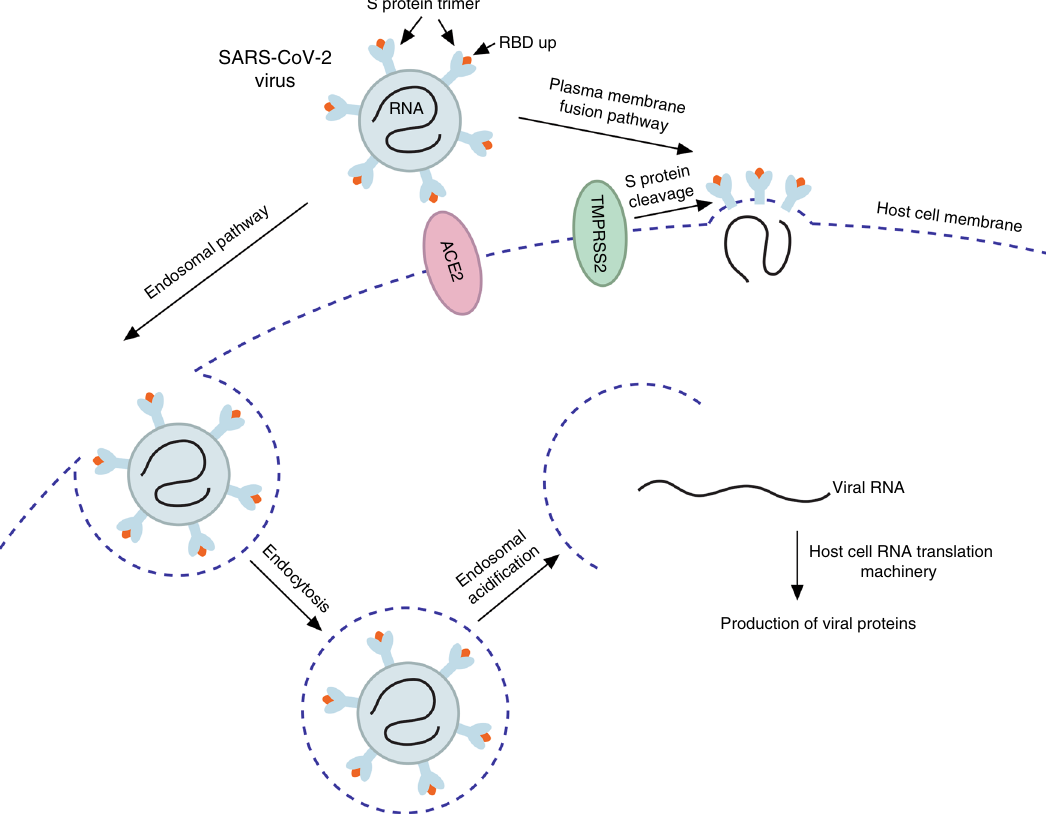
Fig. 2 SARS-CoV-2 infection stages and therapeutic targets. A schematic of the SARS-CoV-2 infection stages and current therapeutic